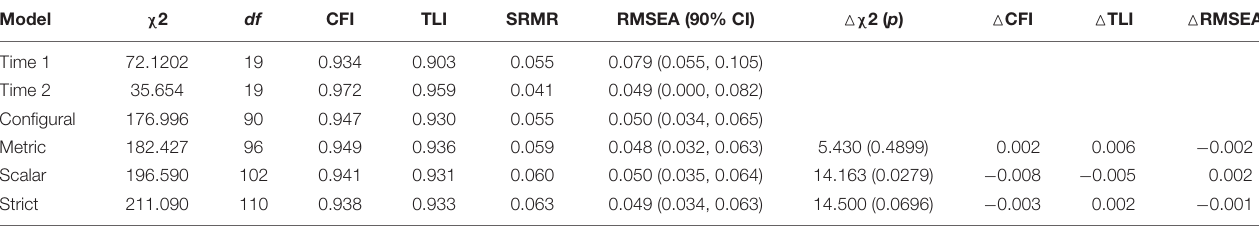
TABLE 3 | Longitudinal measurement invariance model fit statistics for the Short Grit Scale.